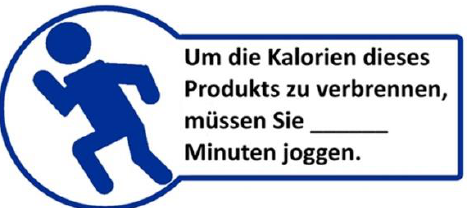
Figure 1. Design of the physical activity calorie equivalent (PACE) label used in the eye-tracking (ET) experiment. The reference text on the claims translated into English reads as follows: “To burn the calories of this product, you have to run for … minutes.”